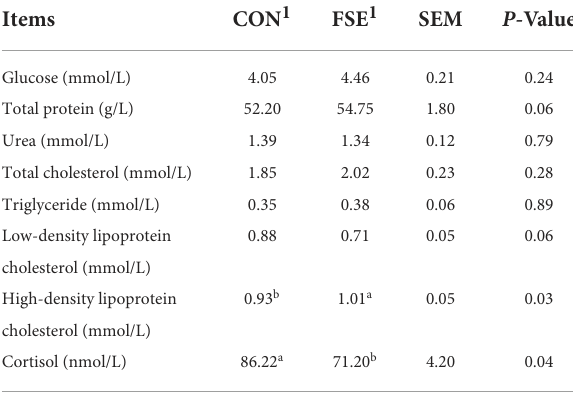
TABLE 5 Effect of Forsythia suspensa extract on serum biochemical indicators of finishing pigs.